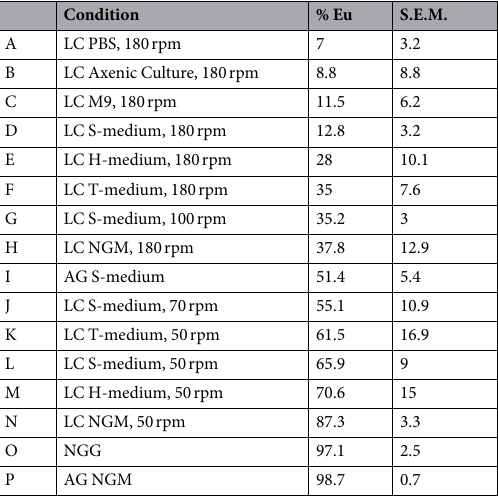
Table 1. Buffer/ions and physical culture state affect mouth-form phenotype. A panel of culturing methods covers phenotypic ratios from ~10–99% Eu. LC = liquid culture, AG = agar, T and H medium = S-medium with phosphate replaced with 50 mM Tris or HEPES, pH 7.5, respectively, NGG = NGM with agar replaced with Gelrite/Gelzan CM (Sigma) 35 . N ≥ 3 biological replicates per condition, and standard error mean (SEM) is presented in the last column. Mouth-form phenotypes were assessed 4–5 days after bleach-synchronization (see Methods).